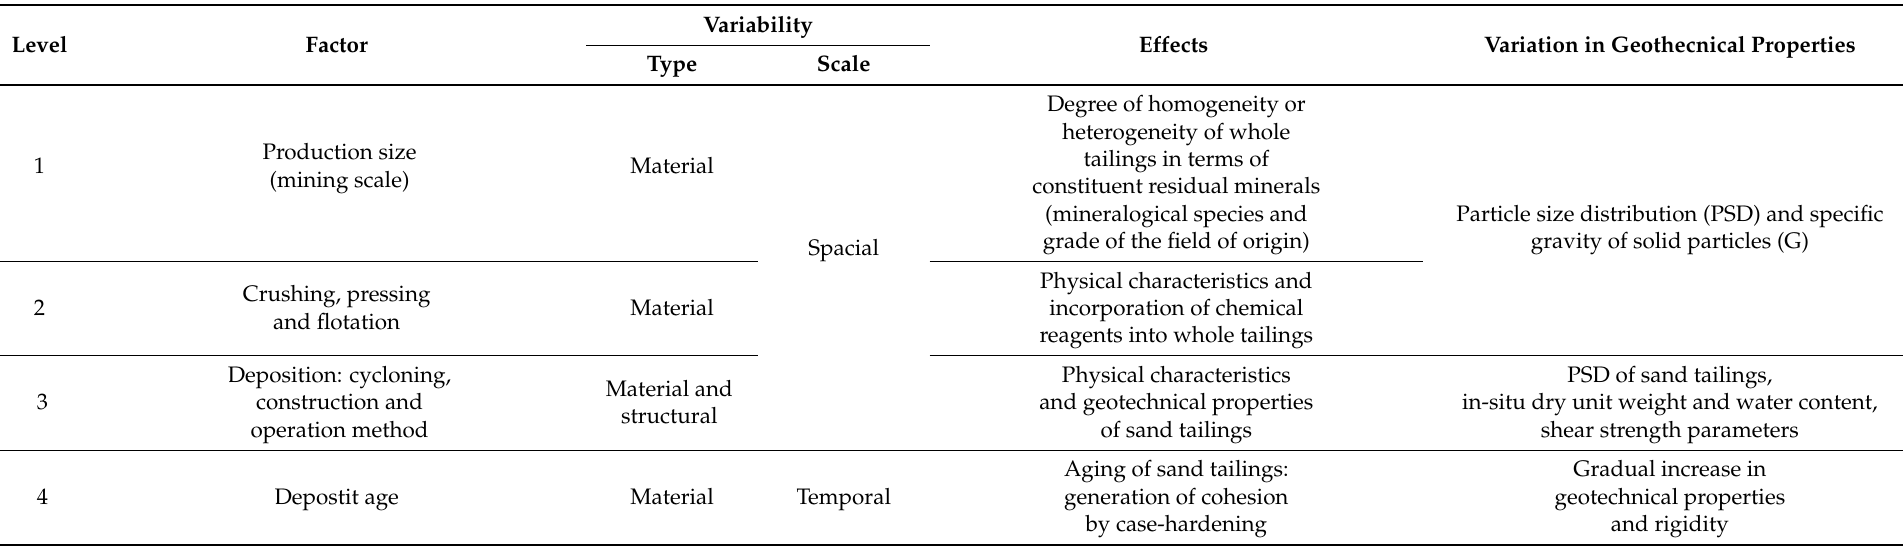
Table 1. Types of variability, associated factors, effects, and variation in geotechnical properties sand